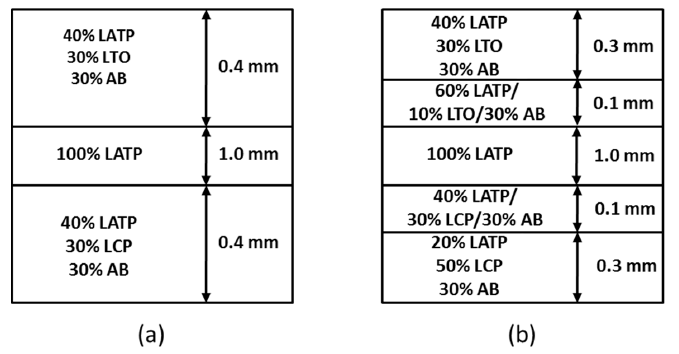
Figure 2. Schematics of ( a ) regular three-layer and ( b ) functionally graded five-layer batteries.